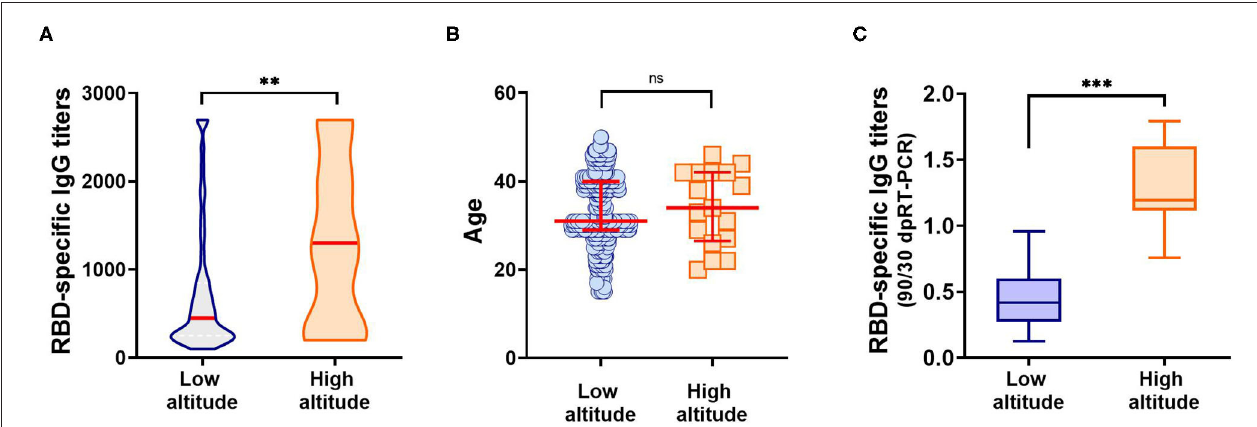
FIGURE 4 | Anti-RBD IgG antibodies elicited in individuals from low (431 mamsl) and high altitudes (2,014 mamsl). (A) Specific IgG titers elicited at day 30 post-SARS-CoV-2 diagnosis, in each population. Red line: median. ** p < 0.01, Kolmogorov–Smirnov test. (B) Age distribution among individuals from the low altitude and high altitude groups studied. No statistical difference was observed between the ages of the low altitude vs. high altitude groups when analyzed by the Kolmogorov–Smirnov test ( p = 0.6277). Mean and standard deviation for each group are depicted in red. (C) Evolution of anti-RBD response against SARS-CoV-2 after 90 days post-diagnosis. Results represent the ratio between RBD-specific IgG titers at day 90 and day 30 post-diagnosis. *** p < 0.001, Kolmogorov–Smirnov test.